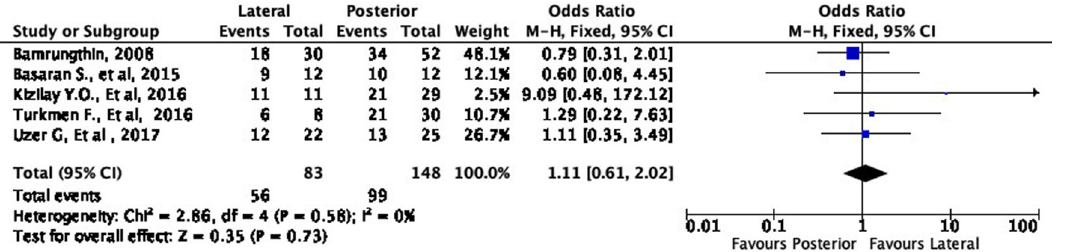
Figure 8. Comparison of cosmetic outcome in the excellent subgroup.